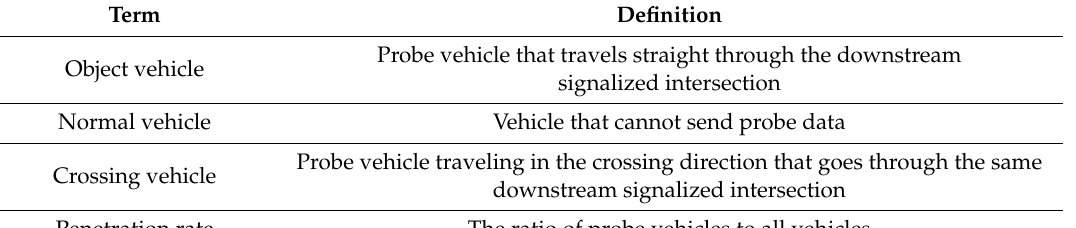
Table 1. Definition of terms related to vehicles.